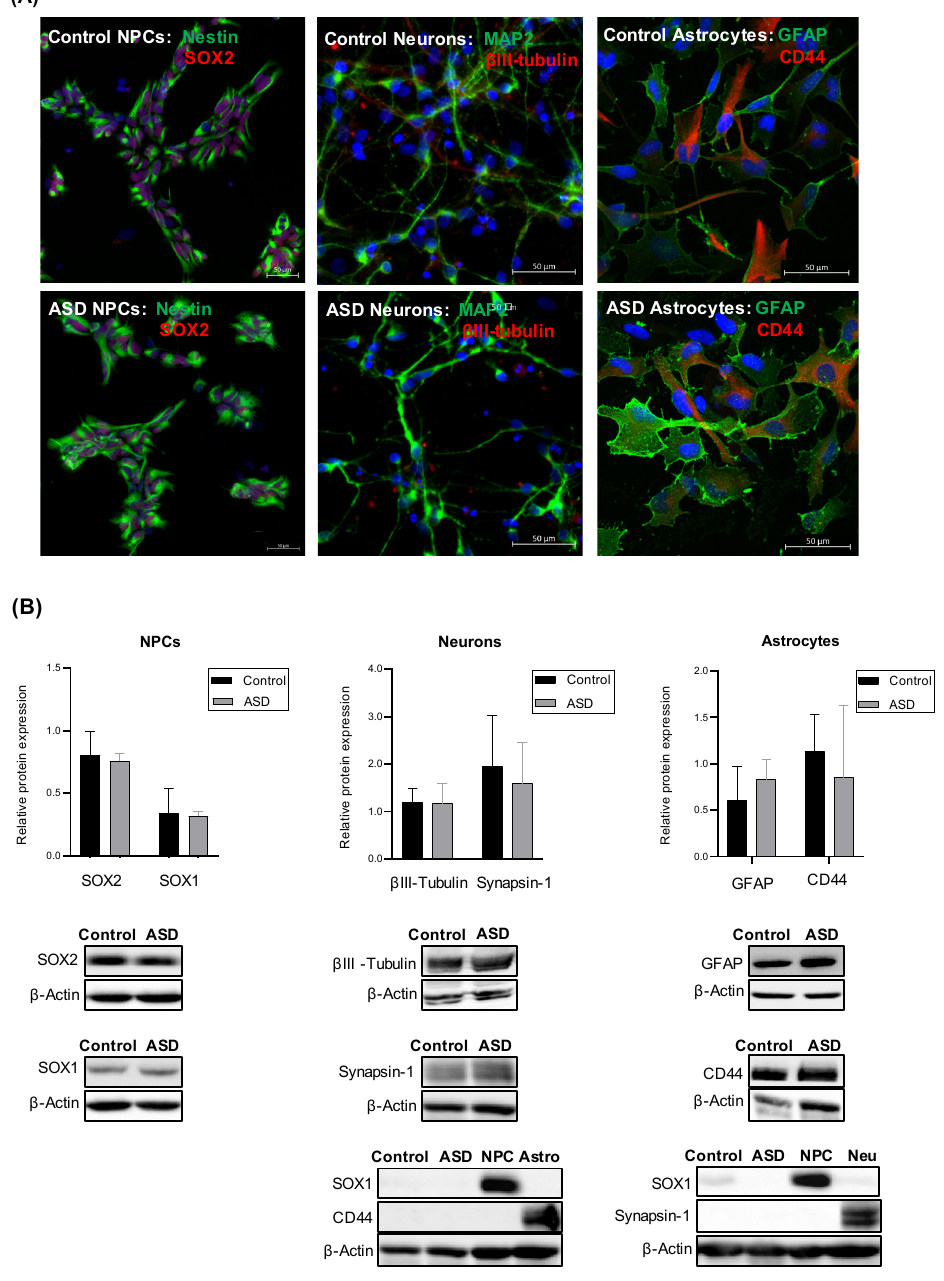
Figure 1. Expression of lineage-specific markers in iPSC-derived NPCs, neurons and astrocytes. ( A ) Representative images of control- and ASD-derived: NPCs, showing the expression of the neural progenitor markers Nestin, an intermediate filament protein, and SOX2, a transcription factor that regulates pluripotency; neurons showing the expression of the neuron-specific cytoskeleton proteins MAP2 and β III-tubulin; astrocytes showing the expression GFAP, one of the major intermedi- ate filament protein of astrocytes, and CD44, a cell adhesion protein expressed by astrocyte precur- sor cells. Nuclei were stained with DAPI (blue). All scale bars represent 50 μ m. ( B ) Relative protein levels of: SOX2 and SOX1 in iPSC-derived NPCs of control ( n = 4) and ASD ( n = 7) subjects; β III- tubulin and Synapsin-1, a synaptic vesicle-associated protein, in iPSC-derived neurons of control ( n = 4) and ASD ( n = 5) subjects; GFAP and CD44 in iPSC-derived astrocytes of control ( n = 4) and ASD ( n = 5) subjects. β -actin was used as a loading control. Representative immunoblot images of each lineage-specific marker are shown. No significant differences in the expression levels of these line- age markers were observed between the control and ASD groups. Furthermore, in order to verify whether the neuron cultures were contaminated by NPCs and astrocytes, as well as whether the